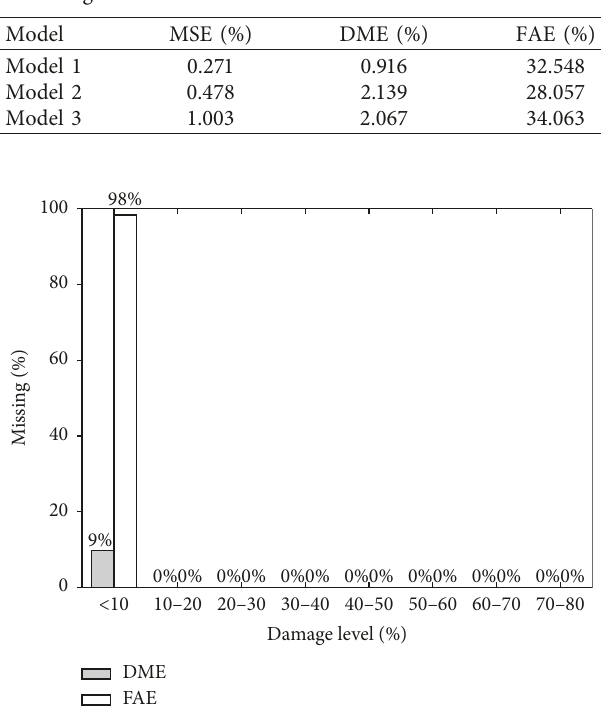
Figure 9: Images for the spring-mass system with (a) no damaged elements and (b) one randomly damaged element. Table 3: Training result summary for the spring-mass system when evaluating the test set.